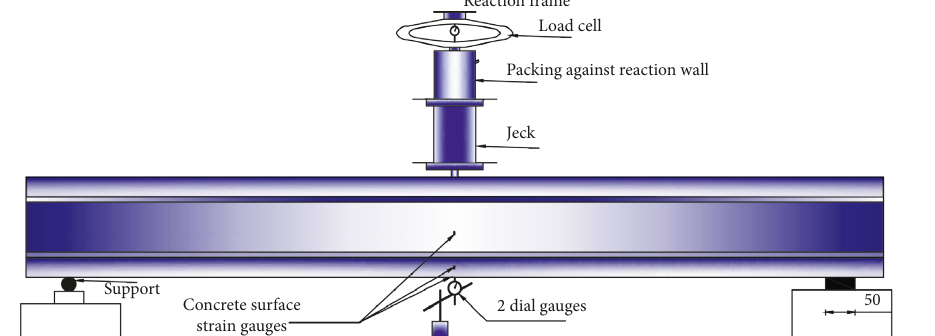
Figure 4: Schematic view of arrangement for the flexural test of girders by the centre point loading method (ASTM C293-02).